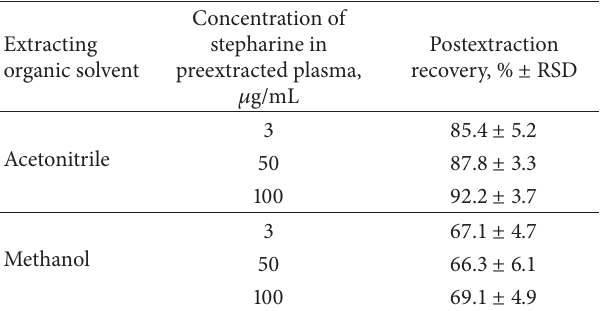
Table 1: Stepharine extraction recovery from rabbit plasma using acetonitrile and